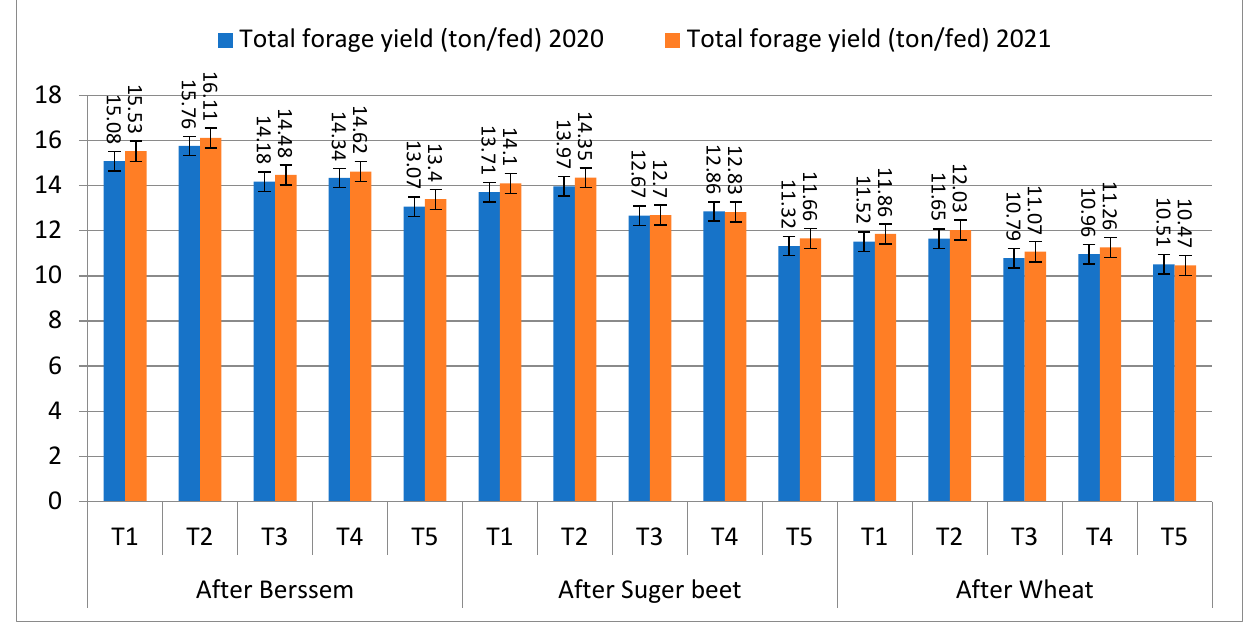
Figure 3. The effect of interaction on cowpea forage yield cuts (ton/fed) under intercropping system during 2020 and 2021 seasons. T1: 100% mineral NPK, T2: 75% mineral NPK + Arbuscular Mycorrhiza fungi, T3: 50% mineral NPK + Arbuscular Mycorrhiza fungi, T4: 75% mineral NPK + Mycrobein, T5: 50% mineral NPK + Mycrobein.